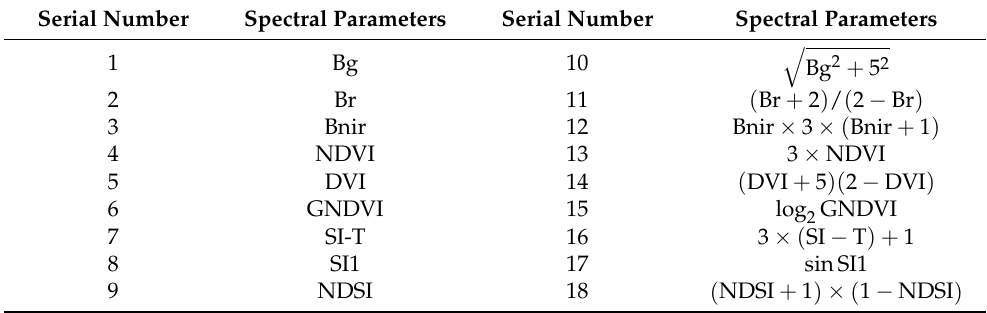
Table 7. Spectral parameters of comprehensive estimation model of soil salinity.